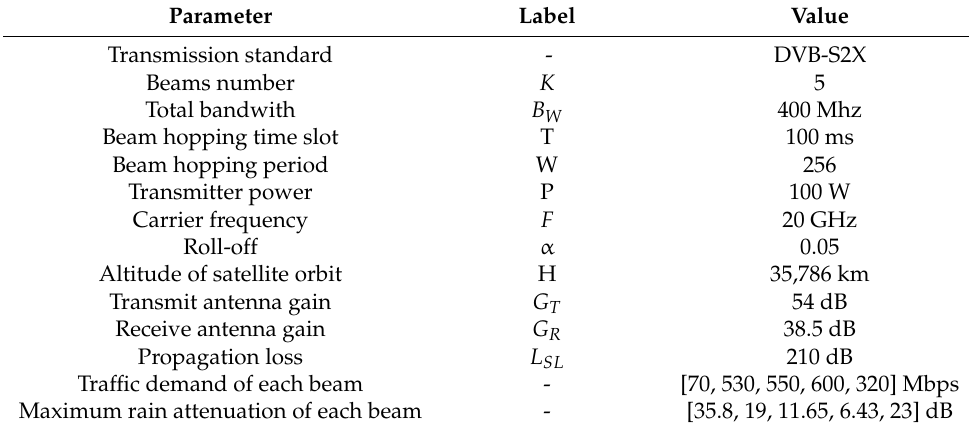
Table 1. Satellite system simulation parameters.